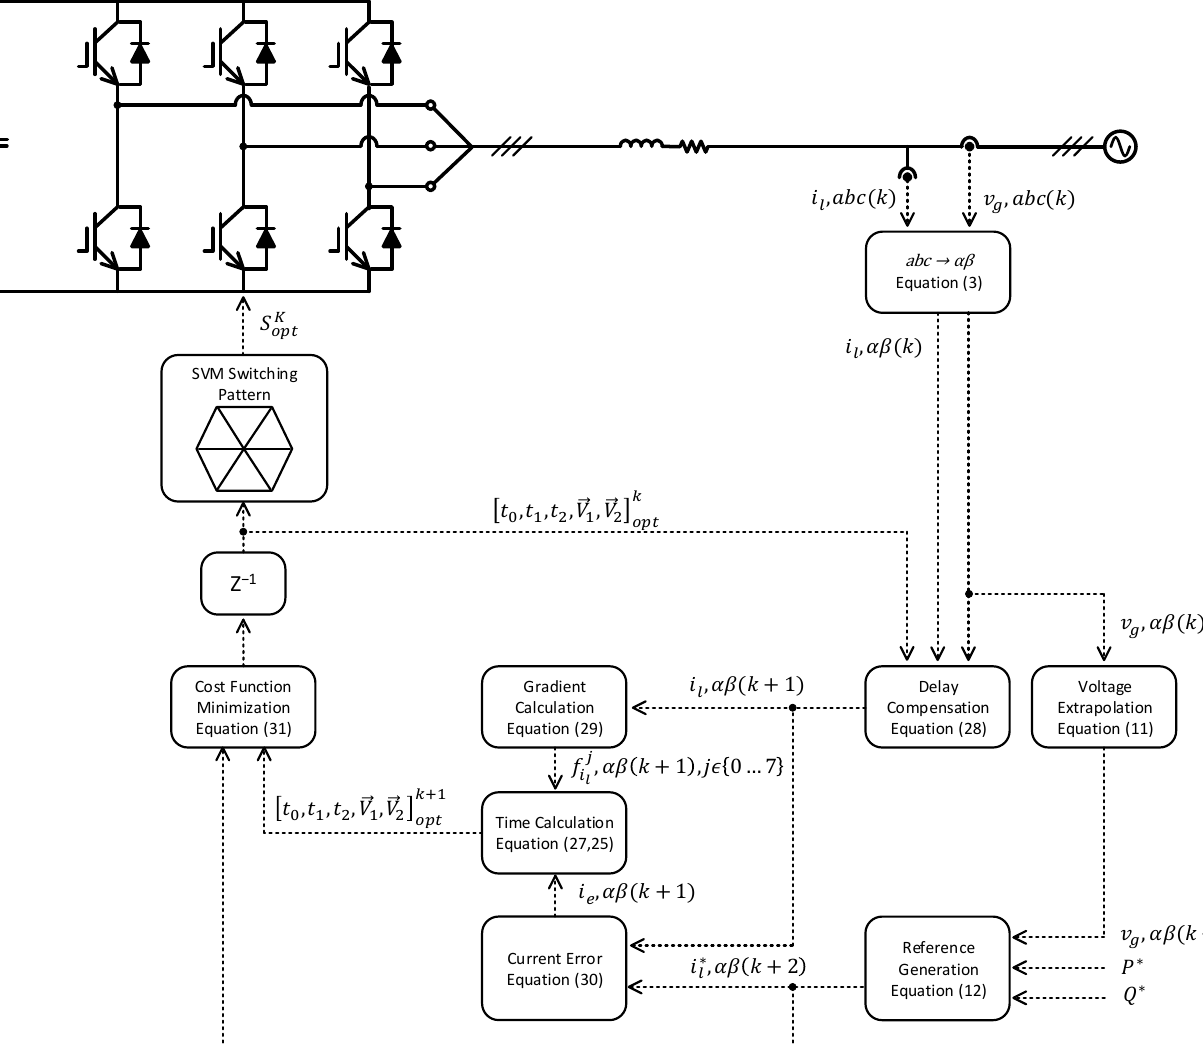
where i e , α ( k + 1 ) and i e , β ( k + 1 ) are the predicted inductor current errors. The null vec- tor application time is not considered in Equation (23) as it can be eliminated from Equation (22) using Equation